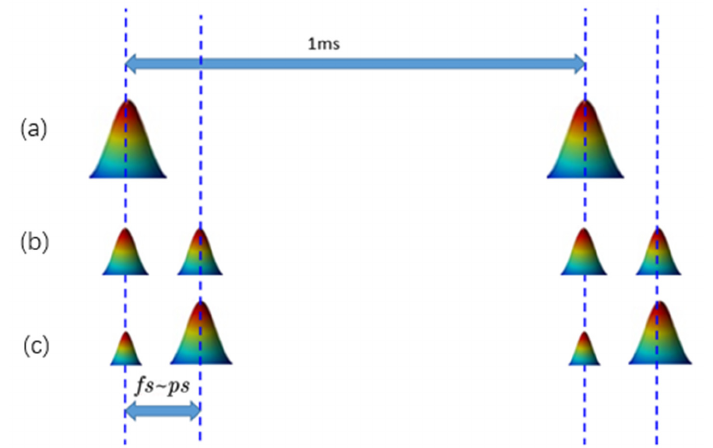
Figure 2. Schematic of the pulses used for ablation, with a single pulse and with double pulses with varying energy ratios: ( a )—single pulse; ( b )—a double pulse with an energy ratio of 5:5; ( c )—double pulses with a different energy ratio (1:9 or 2:8). The maximum repetition rate of the laser was 1 kHz.